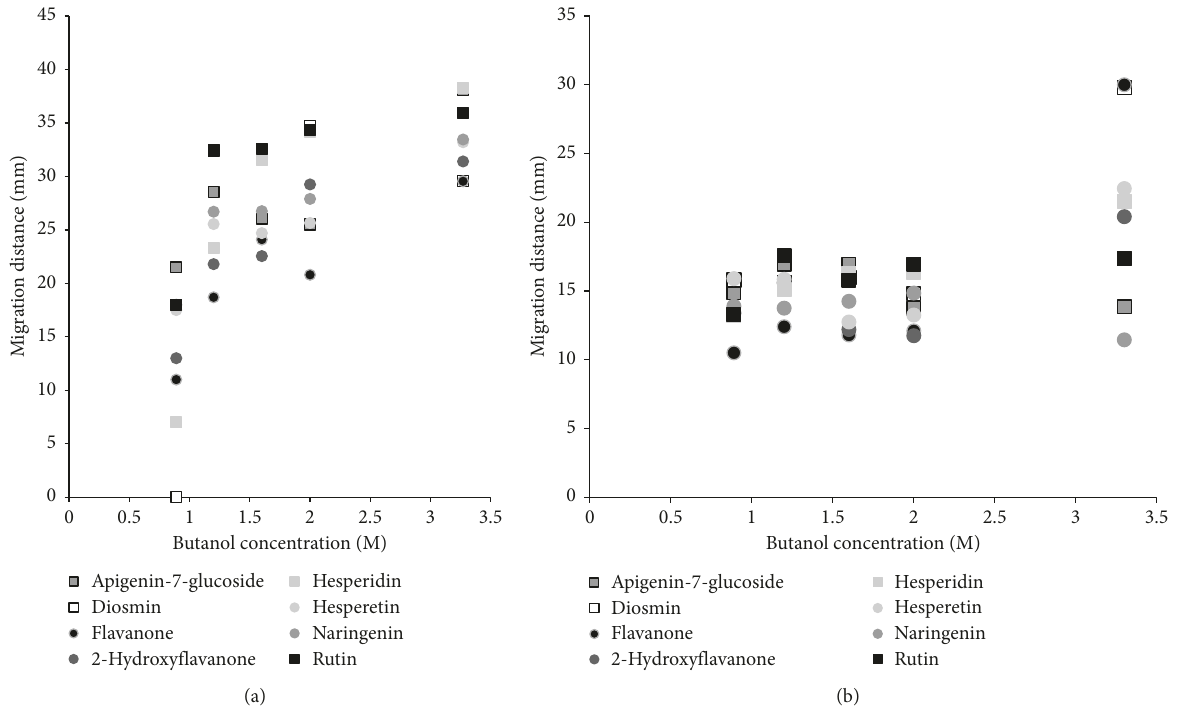
Figure 3: Migration distance of flavonoids vs. butanol concentration in the mobile phase for HPTLC (a) and PPEC (b) experiments. The mobile phase: butanol (0.89–3.27M; 8.14–30.00% v/v), 10% acetonitrile, 0.1144M SDS, and aqueous buffer of pH 7.0 (0.88 mM of citric acid and 8.23 mM of disodium hydrogen phosphate). The stationary phase: HPTLC RP-18W. TLC: experiment time 20min. PPEC: polarization voltage 800V; experiment time 8min.